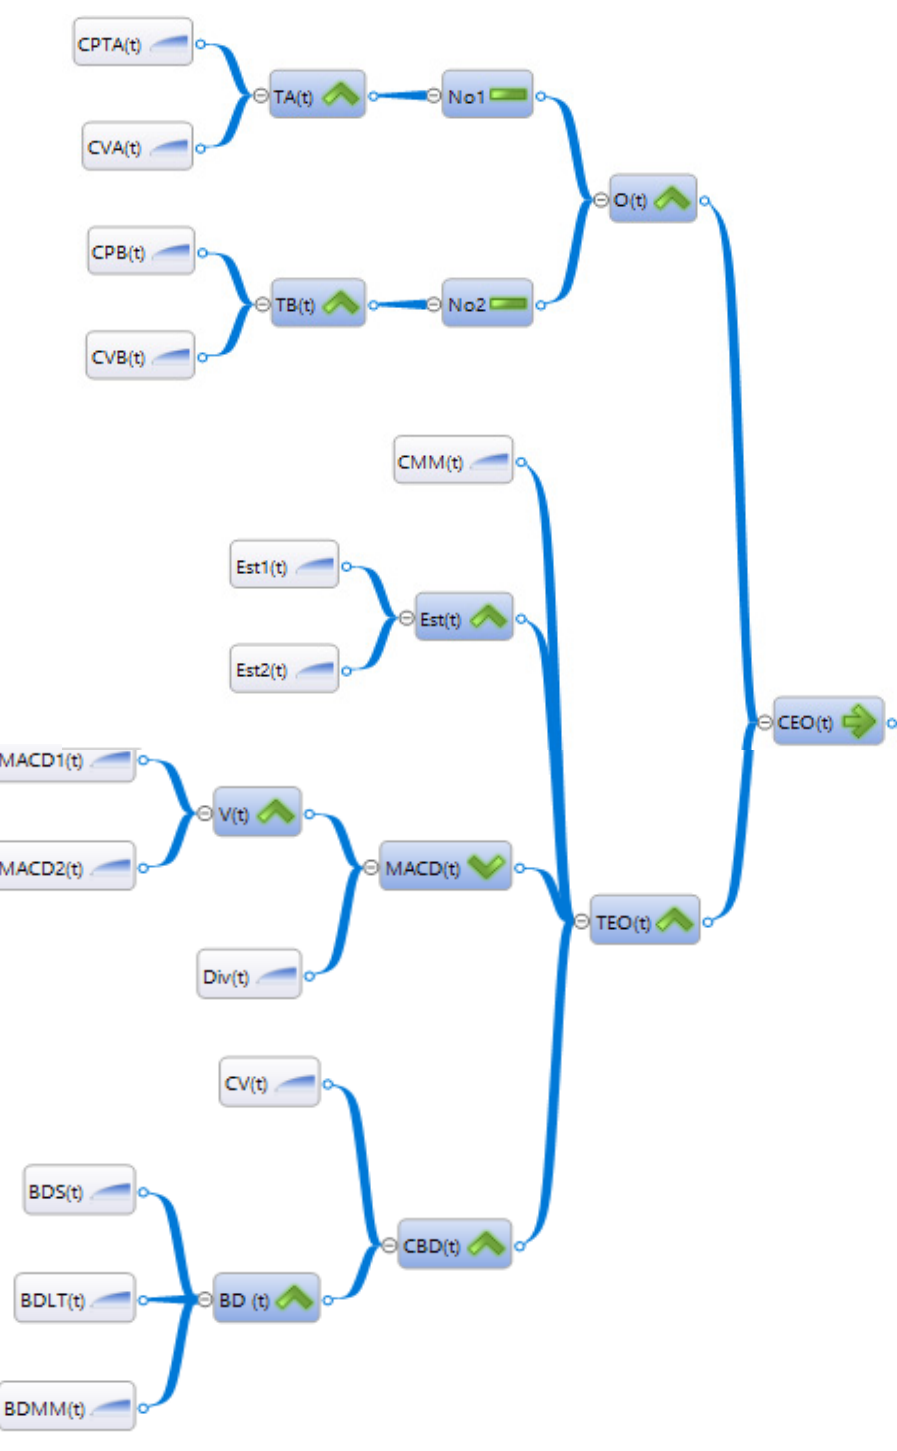
Figure A3. Logical tree representing the truth degree of the composed predicate “there are good oscillation conditions for selling at time t ”, CEO ( t ).